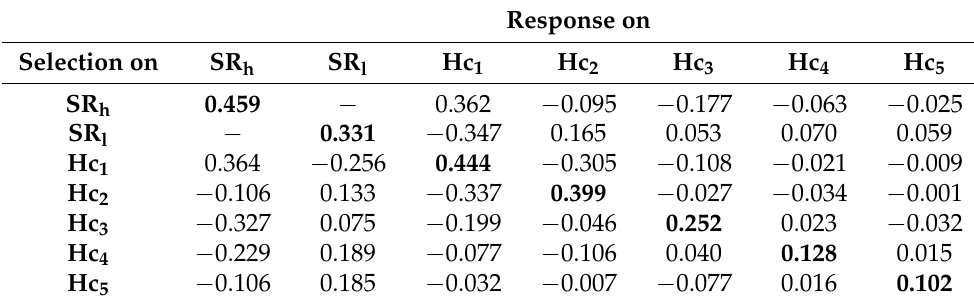
Table 7. Predicted selection response 1 from the same trait (on diagonal and bold) and from different traits 2 (off diagonal) in ungenotyped